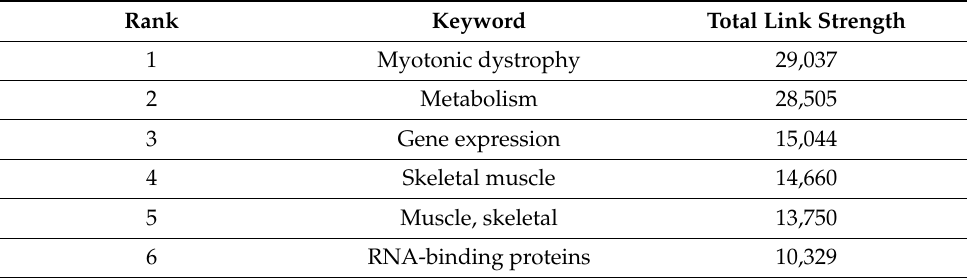
Table 1. Top six keywords from the global network visualization map. In the network visualization map, a link expresses a co-occurrence association between keywords. These links have a strength identified by a positive number; a higher number indicates a stronger link. The total link strength indicates the total number of publications in which two keywords appear. Rank Keyword Total Link Strength 1 Myotonic dystrophy 29,037 2 Metabolism 28,505 3 Gene expression 15,044 4 Skeletal muscle 14,660 Muscle, skeletal 13,750 6 RNA-binding proteins